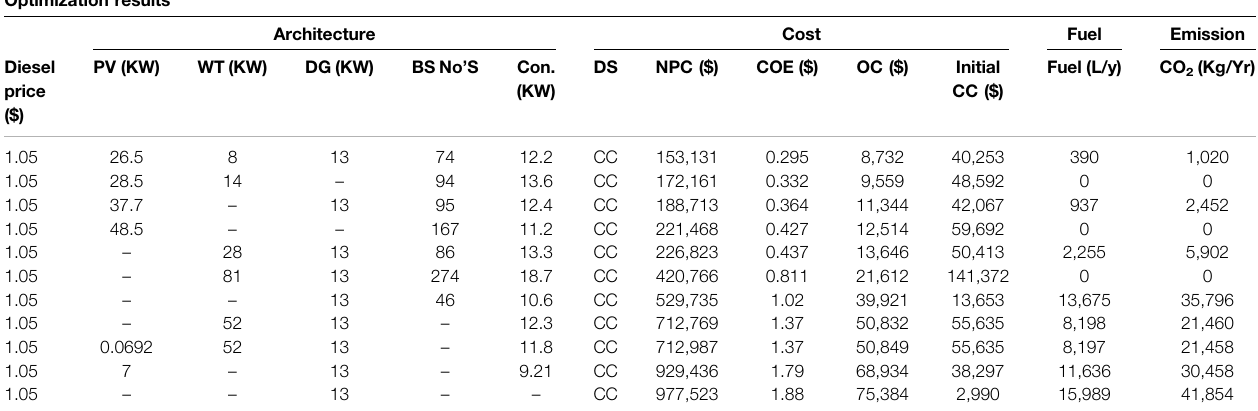
TABLE 9 | HOMER optimization results of the PV/Wind/Diesel/Battery system for Kanyakumari. Optimization